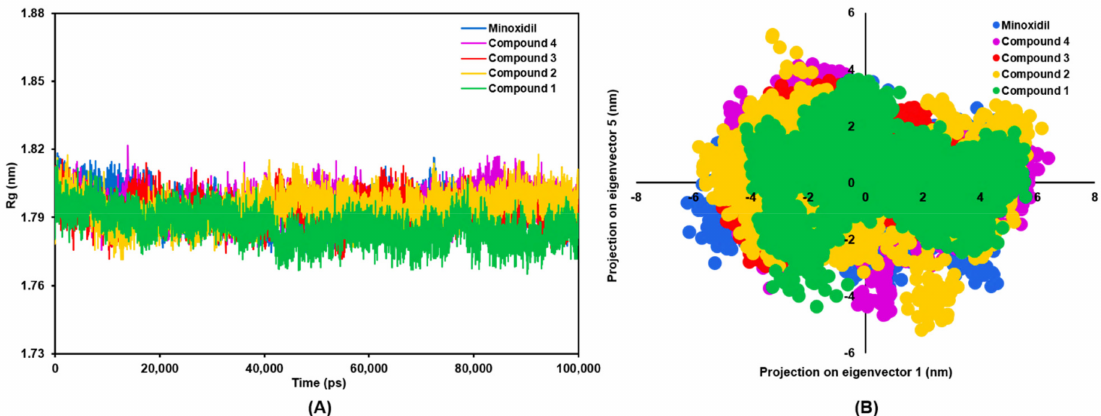
Figure 4. The plots of ( A ) radius of gyration of backbone atoms for AR-compound complex, and ( B ) principal component analysis of the projected trajectory in 2D, during 100 ns of